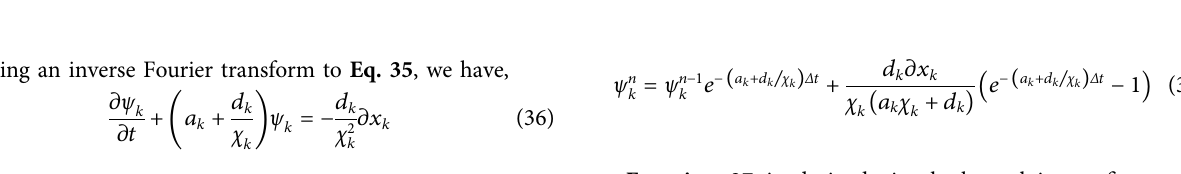
Frontiers in Earth Science |